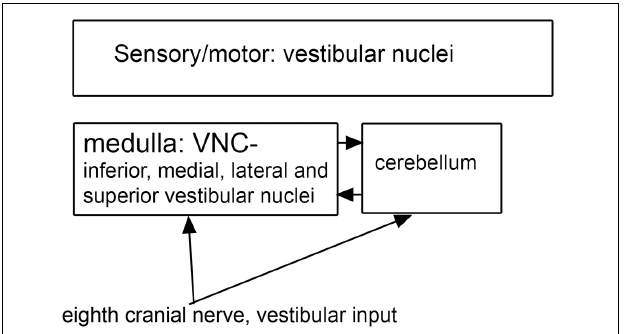
FIGURE 5 | Vestibular input to the vestibular nuclei of the